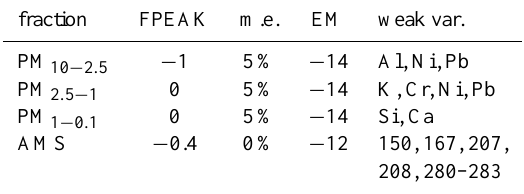
Table 2. Settings chosen for the PMF calculations, for each